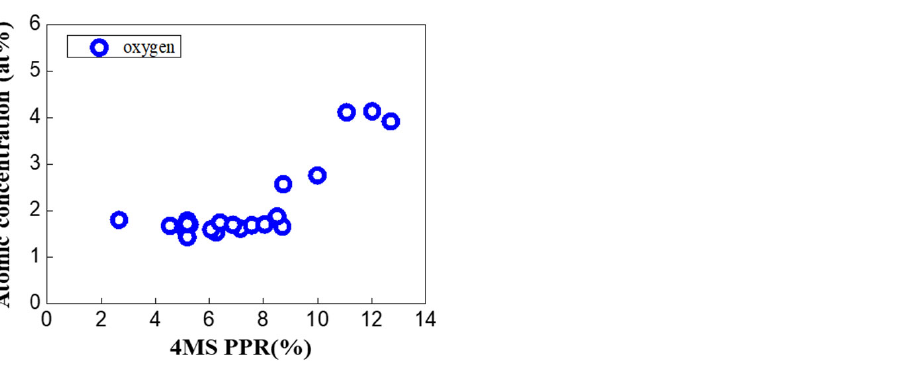
Figure 4. Oxygen concentration according to the 4MS PPR. In this experiment, the 4MS PPR increased to over 8%.